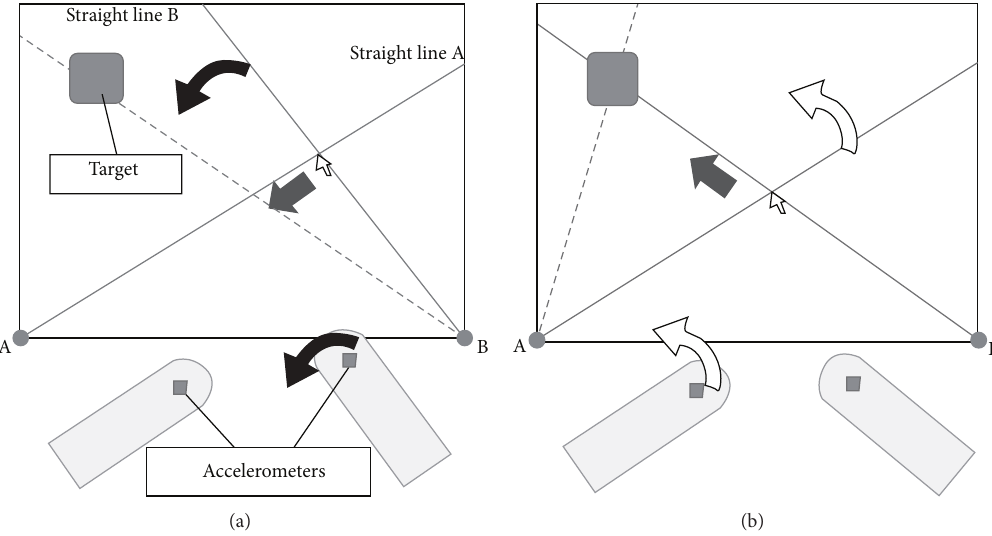
Figure4:Theaccelerometermouseplacesthecursorattheintersectionoftwolines.(a)Movingtheinertialsensor(inthiscase,accelerometer) on the right hand or elbow rotates line B about the screen’s bottom right corner (i.e., point B). (b) Moving the inertial sensor (again, accelerometer) on the left hand or elbow rotates line A about the screen’s bottom left corner (i.e., point A). Images from [19].